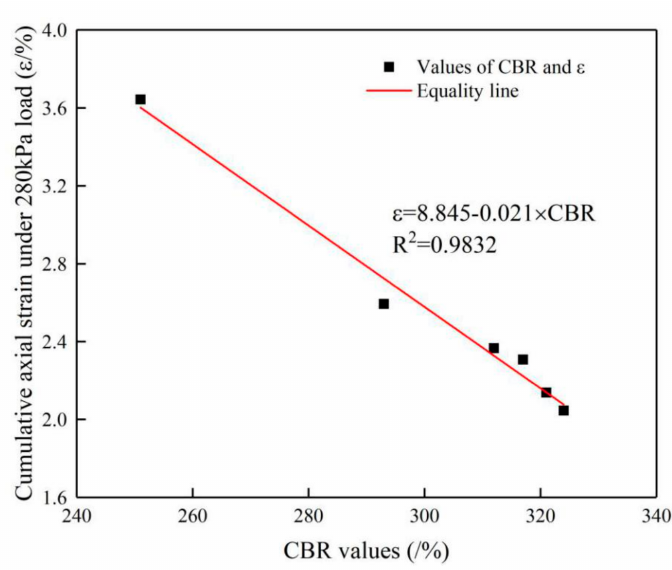
Figure 17. Relationship between CBR values and cumulative axial strain under a 280 kPa